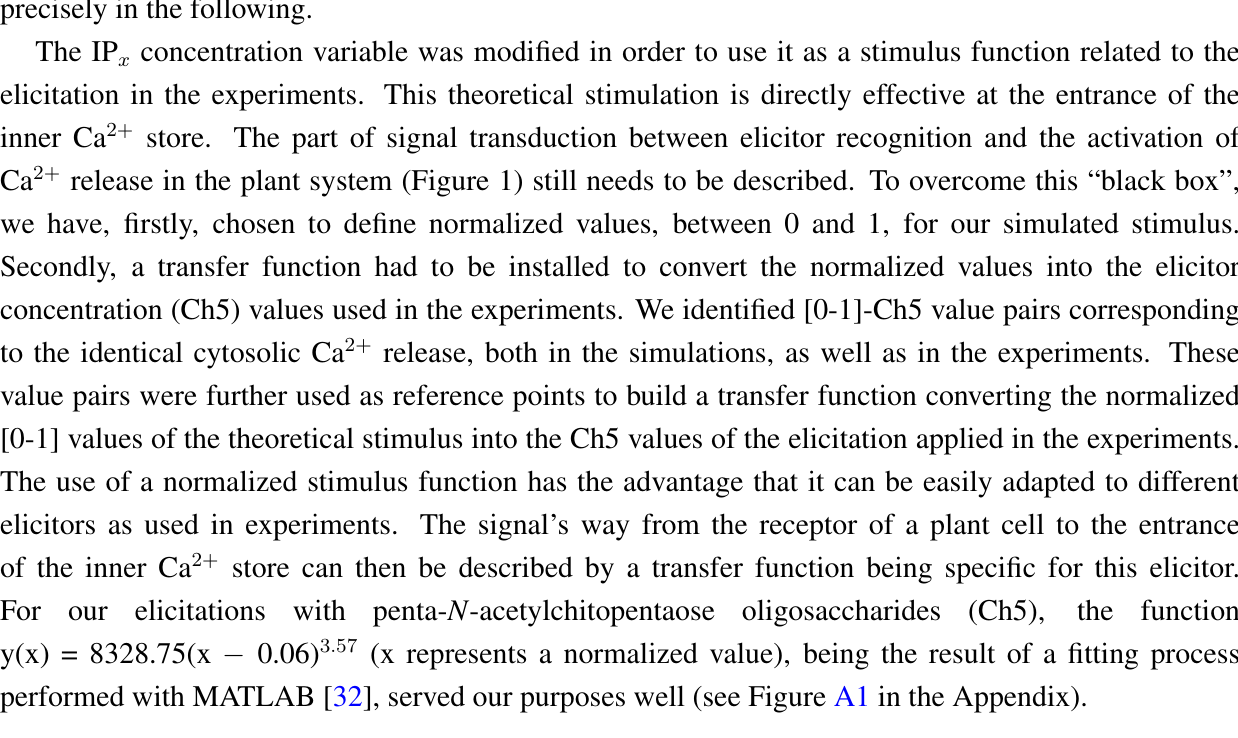
Minimal model for the generation of calcium transients in plant cells upon stimulation by pathogen-associated molecular patterns (PAMPs). Elicitor